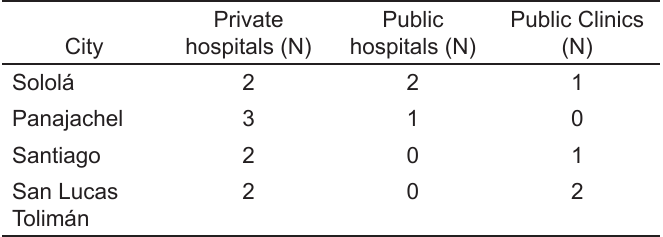
Table. Number of facilities of each type in the four studied Guatemalan